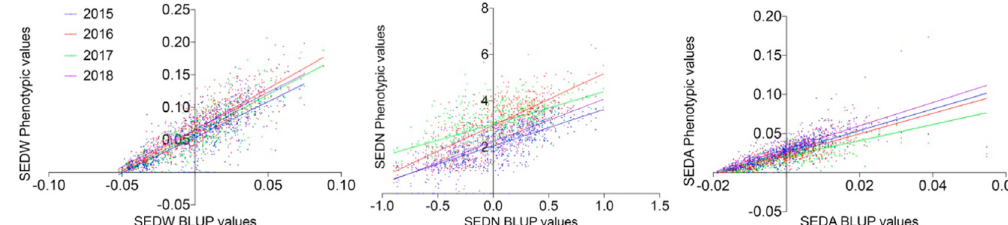
Figure 2. Correlation between phenotypic values for SEDW, SEDN, and SEDA with their respective best linear unbiased predictors (BLUPs). For all the four evaluated seasons (2015–2018), the average R2 was 0.7453, 0.5042 and 0.6204 for SEDW, SEDN, and SEDA, respectively, with p <